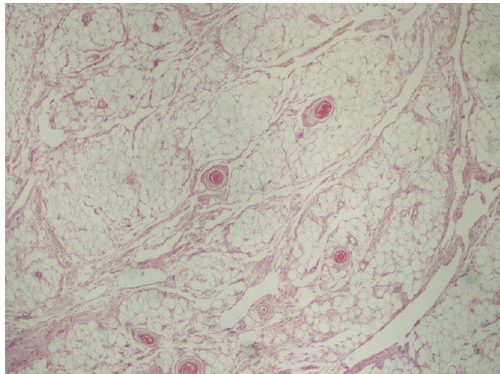
Figure 3: Low-power view of the tumour. Islands of adipocytes are surrounded by loose fibrous septa with artefactual clefts giving a pseudo-angiomatous appearance (H&E